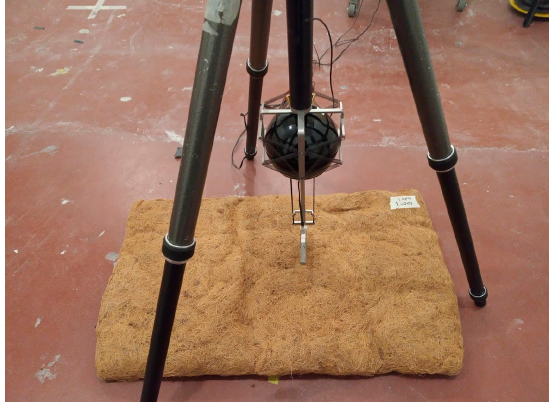
Figure 13. Sound absorption measurement